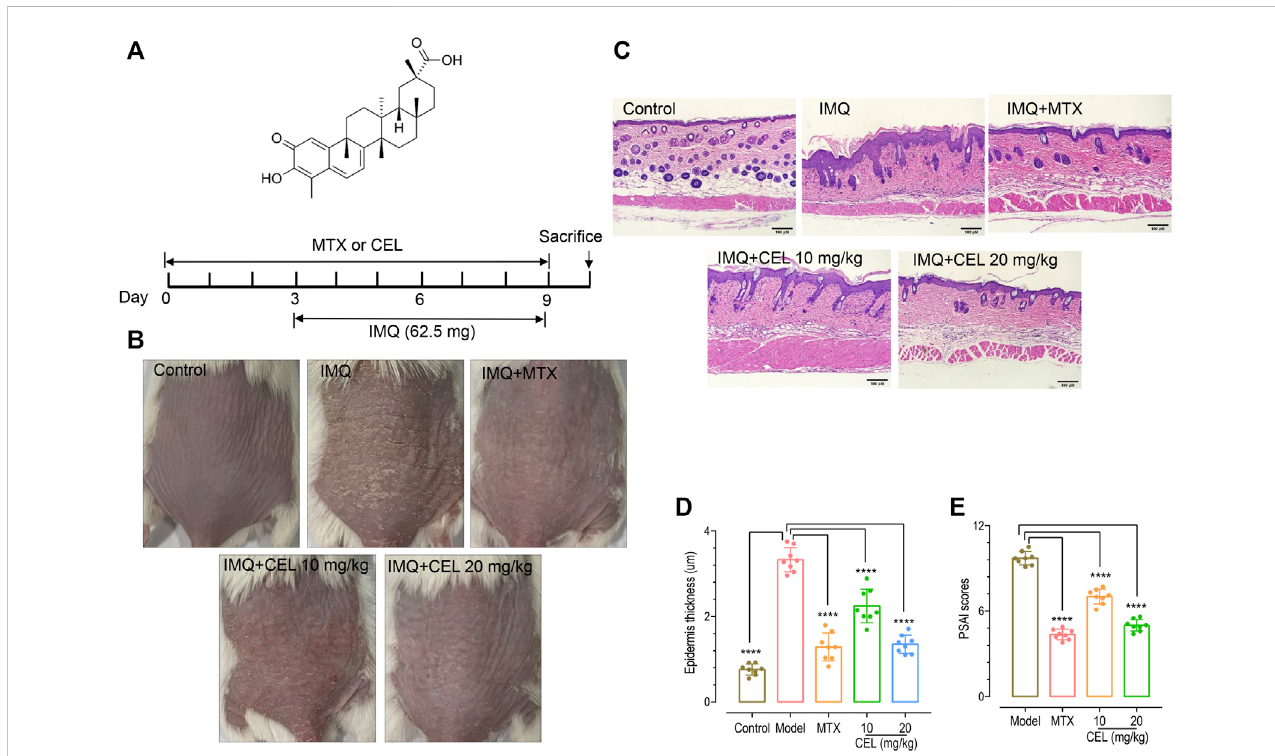
FIGURE 1 Celastrol ameliorated skin symptoms and inhibited epidermal hyperplasia in IMQ-induced psoriasis-like mice. (A) Structure of celastrol (top) and the timeline of various treatments (bottom). BALB/c mice were orally administered with celastrol (CEL-L: 10 mg/kg; CEL-H: 20 mg/kg) or MTX (1 mg/kg) for 10consecutivedaysduringthetopicalapplicationof65 mgIMQonthedorsalskin.Allmiceweresacri fi cedonday10. (B) Representativeimagesofdorsalskin of mice on day 9. (C) Hematoxylin and eosin (H&E) staining of skin tissue from different groups of mice (magni fi cation × 200, scale bar = 50 μ m).